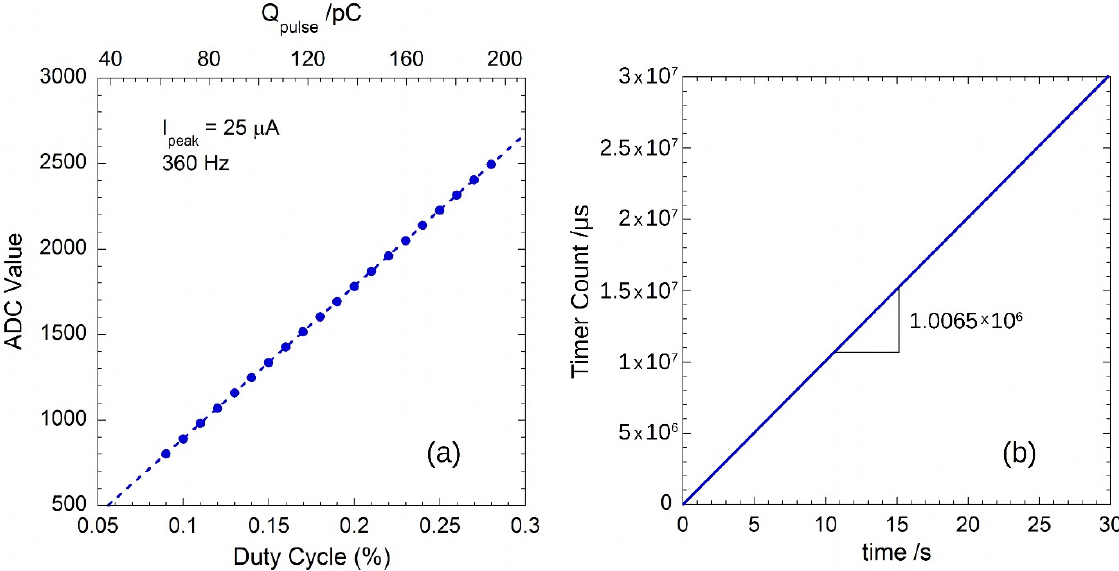
Figure 4. ( a ) Mean value of the ADC codes recorded for pulses at 360 Hz with a duty-cycle in the range 0.09–0.27%. The values of the injected charge pulses are shown on the top axis. Error bars are within the dimension of symbols. A C INT = 96.42 pF is estimated by best fit (blue dotted line) of experimental data (see text); ( b ) SCT count values with a resolution of 1 µs set by means of the prescaler. Timer counts refer to the acquisitions of a train of current pulses with PRF = 360 Hz generated by a Keithley 6221.